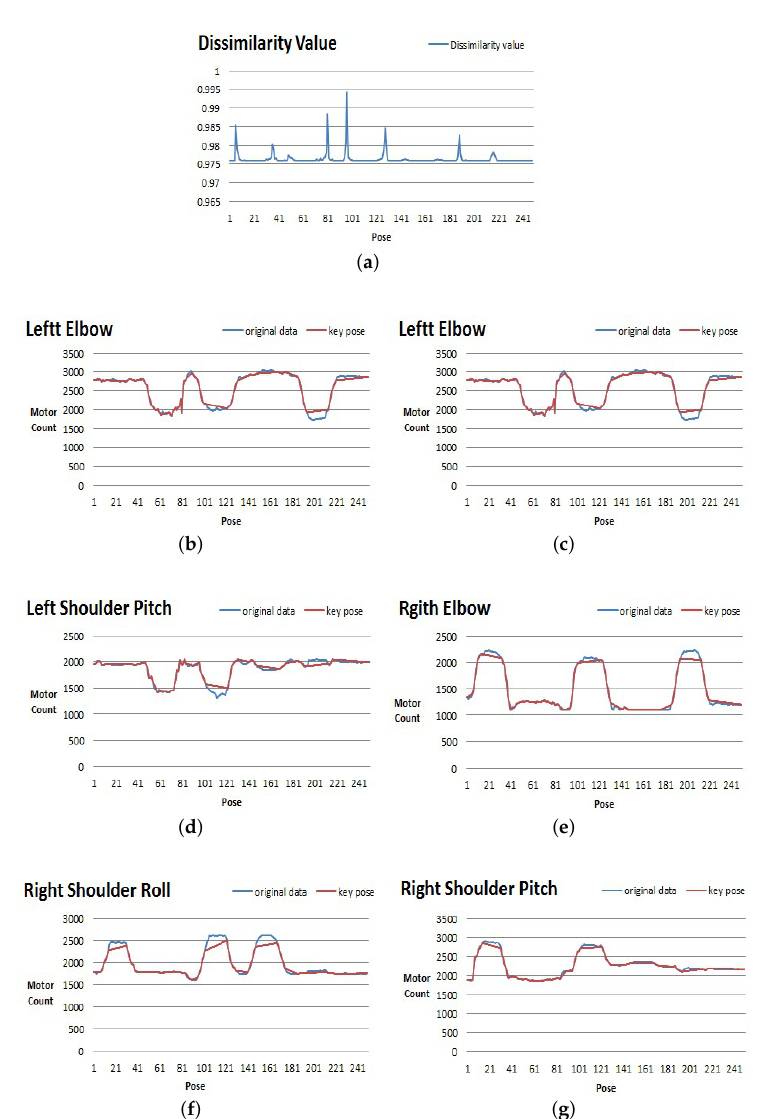
Figure 10. Results of [18] key-pose detection algorithm based on dissimilarity versus original pose data: ( a ) Calculated dissimilarity value. ( b ) Motor counts data on Left Elbow. ( c ) Motor counts data on Left Shoulder Roll. ( d ) Motor counts data on Left Shoulder Pitch. ( e ) Motor counts data on Right Elbow. ( f ) Motor counts data on Right Shoulder Roll. ( g ) Motor counts data on Right Shoulder